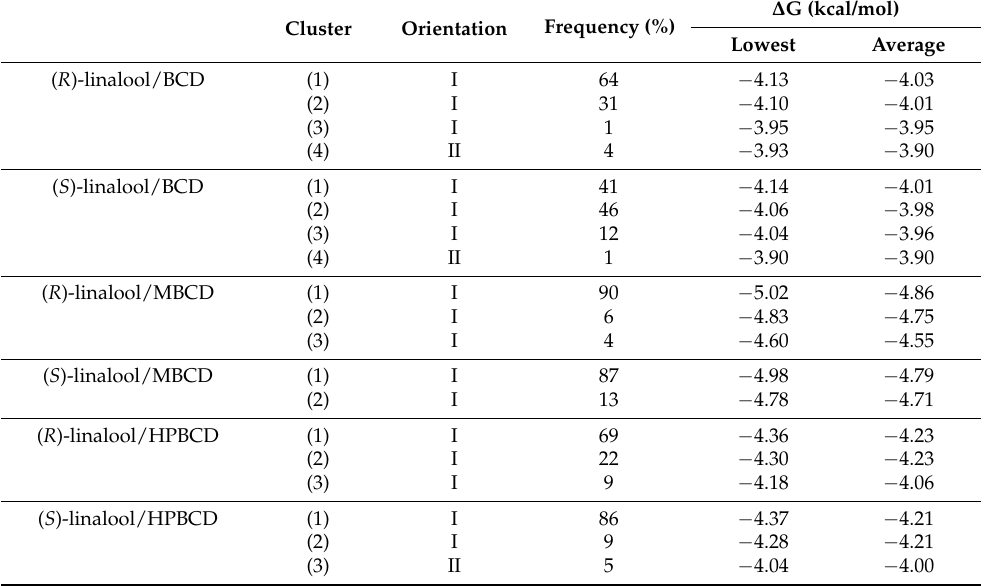
Table 1. The lowest and the average Gibbs free energy ( ∆ G) of linalool/BCD, linalool/MBCD, and linalool/HPBCD inclusion complexes and the number of conformations in a cluster (frequency) obtained from molecular docking calculations.